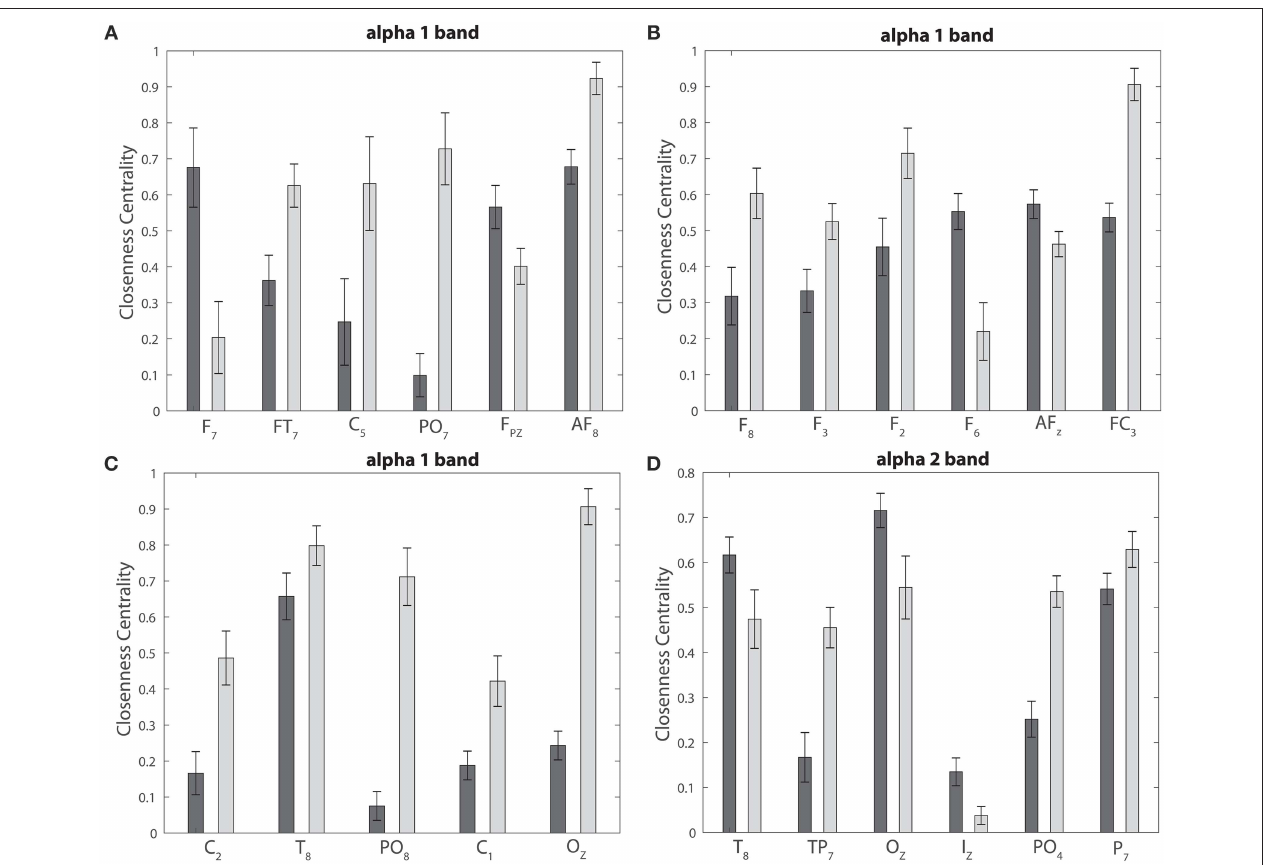
FIGURE 12 | Statistical comparison and closeness centrality. (A–C) Depict the closeness centrality for the realized and imagined tasks considering the significant nodes for the alpha 1 band. (D) Is the same as (A–C) but considering the alpha 2 band. In all cases: dark gray bars, realized task; light gray bars, imagined task. bands allow us to discriminate between both assignments.